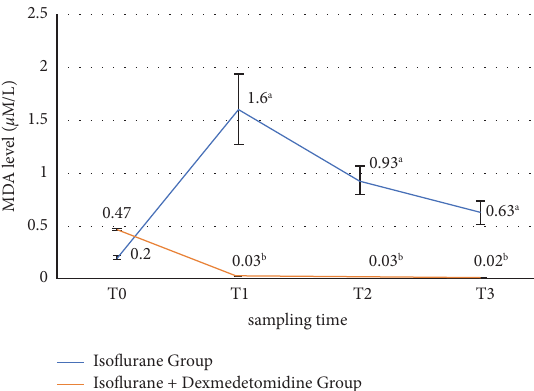
Figure 6: Comparison of MDA enzyme activity ( µ M/L) in group A and group B. T 4hours after anesthesia induction. T 2 � at 8hours of anesthesia induction, T 3 � at 16hours of anesthesia induction. Error bars are SD. Superscripts (a, b) shows the statistical diference among diferent time interval between two groups ( P < 0 . 05), (repeated measures ANOVA followed by pairwise comparison).